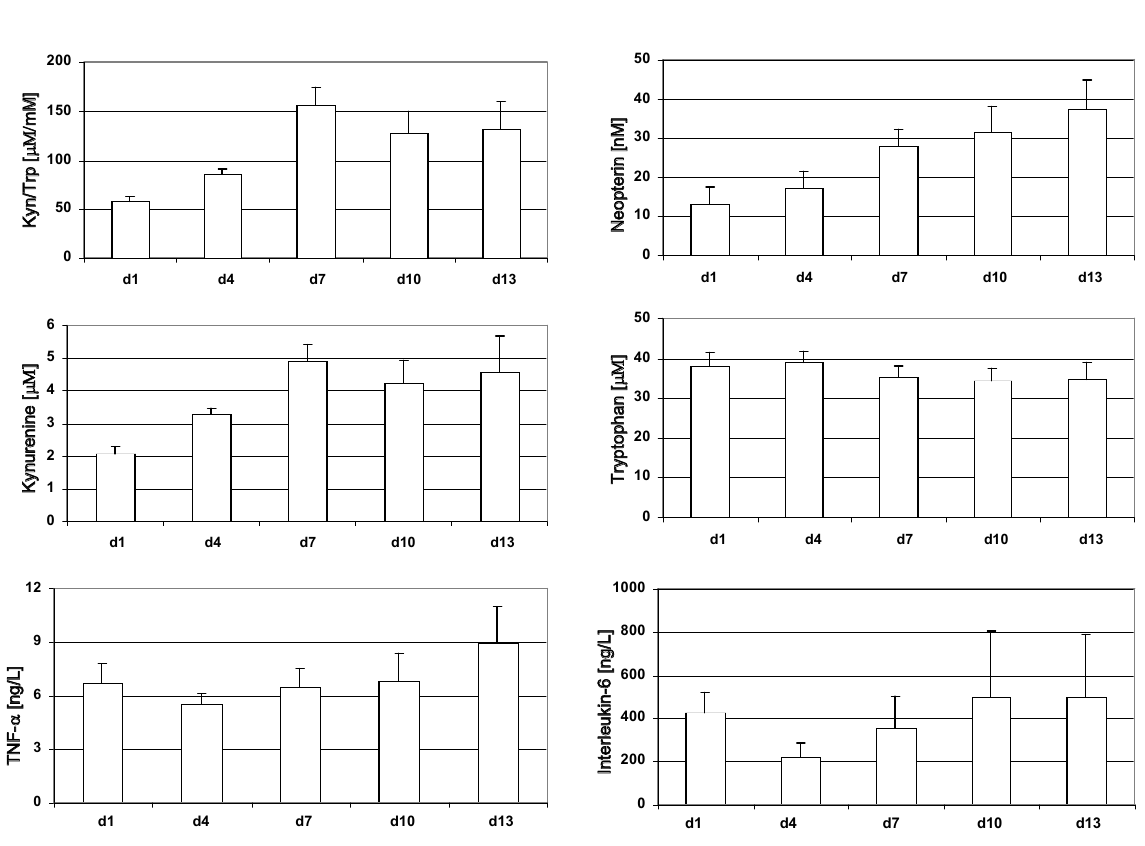
Figure 1. Development of serum kynurenine to tryptophan ratio (kyn/trp; upper left) and of neopterin (upper right), kynurenine (all p < 0.001; lower left), tryptophan (lower right; not significant), tumor necrosis factor- (TNF- α ; lower left; not significant) and interleukin-6 (p = 0.001; lower right) concentrations in patients after mul- tiple trauma or with sepsis during follow-up for 2 weeks (mean ± S.E.M. is